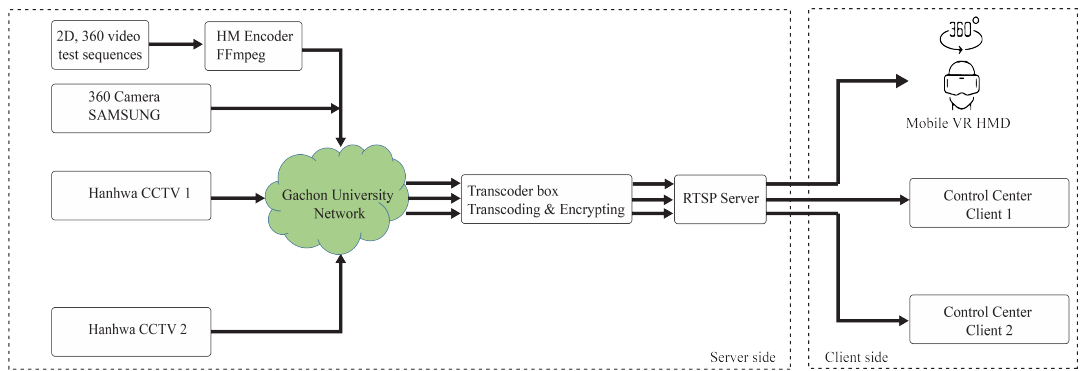
Figure 12. Testbed for live CCTV system.